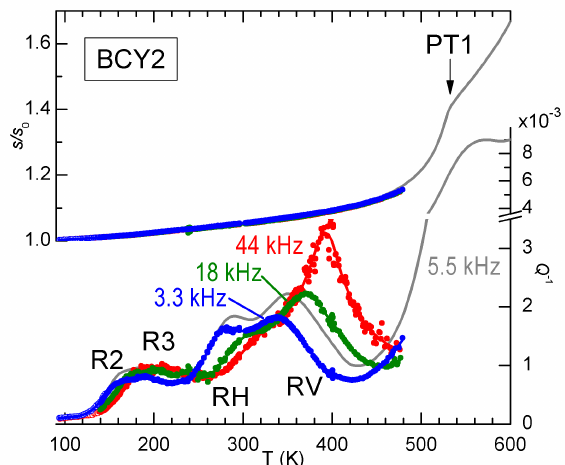
Figure 8. Anelastic spectra of partially hydrated BCY2 measured at three frequencies (data from Ref.